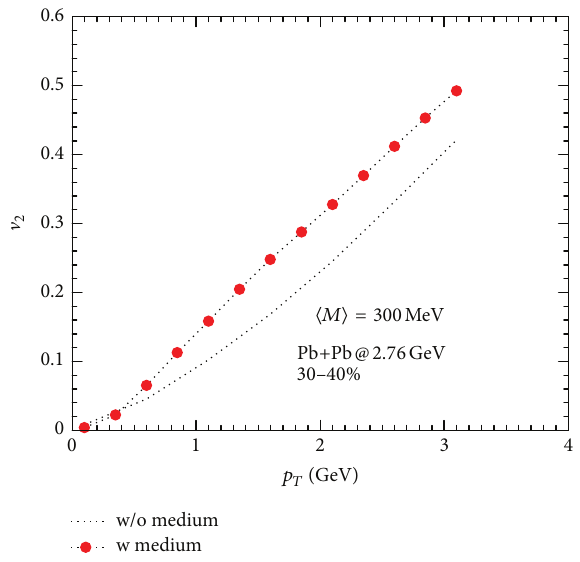
Figure 42: The figure displays the effect of the broadening of 𝜌 spectral function on the elliptic flow for ⟨𝑀⟩ = 300 MeV.